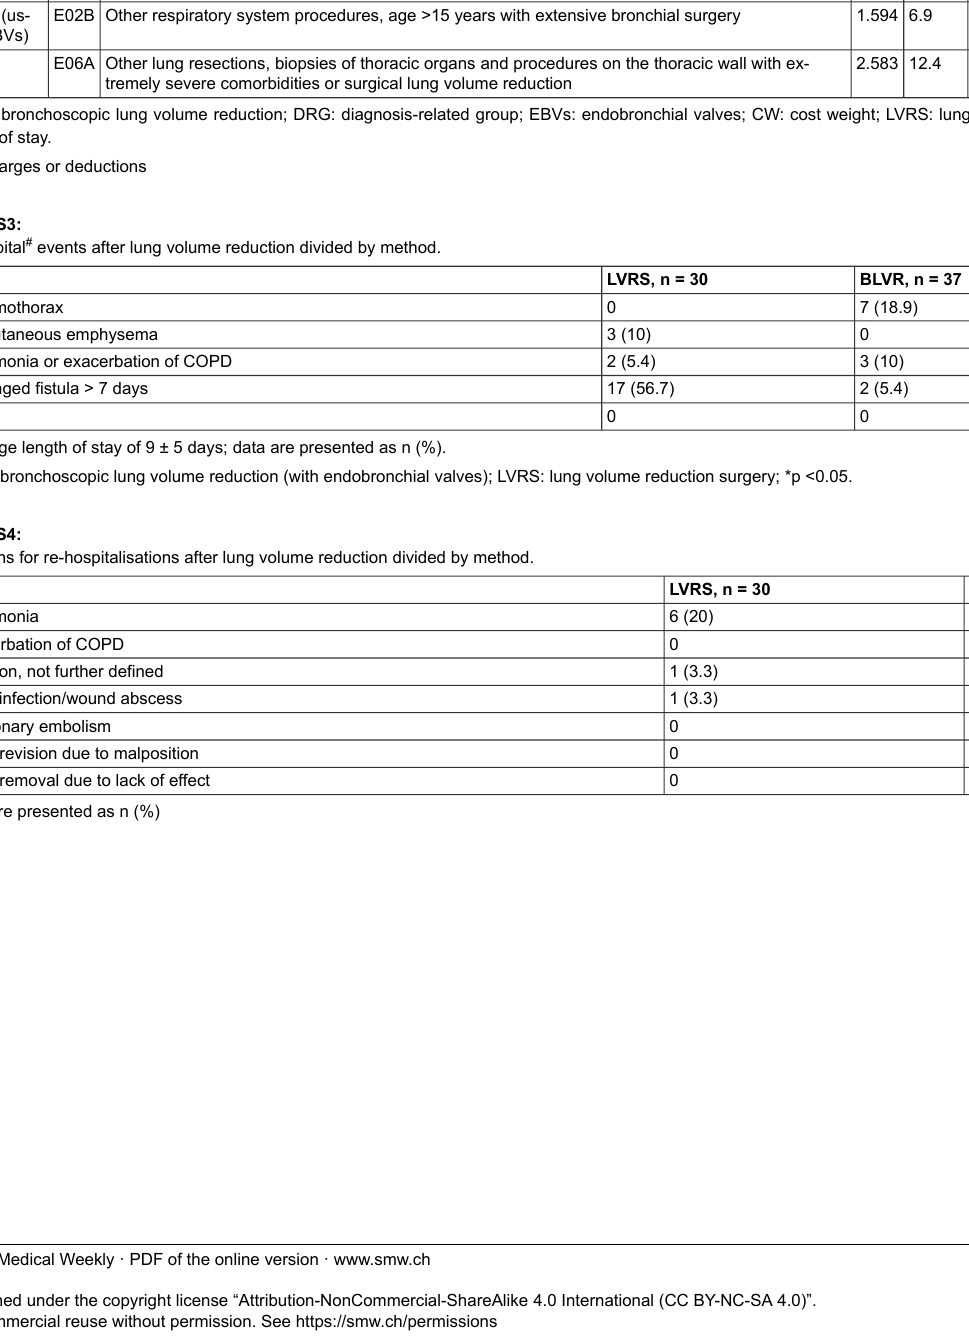
Table S2: DRG according to SwissDRG [24] for lung volume reduction for emphysema. LVR method